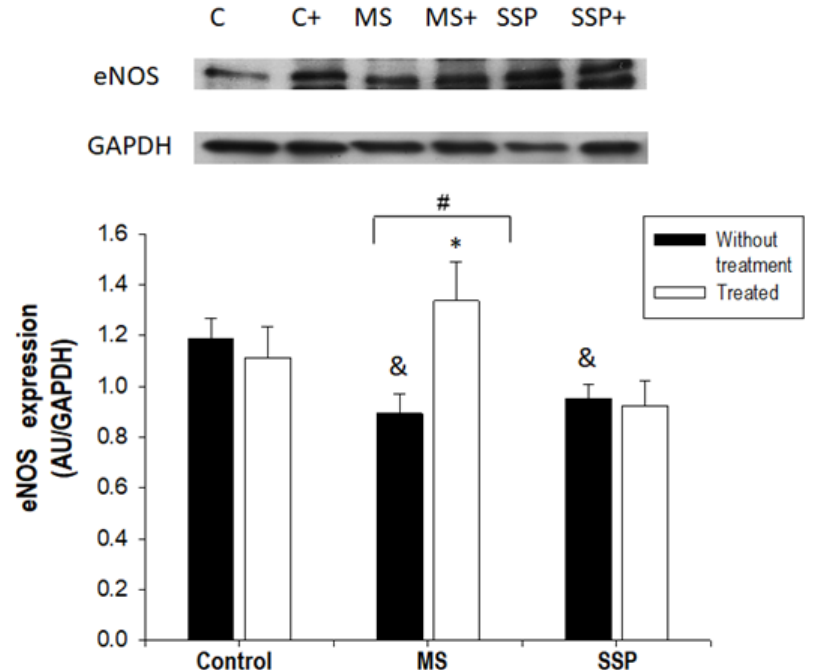
Figure 3. Effect of the treatment for 1 month (from 6 to 7 months of age) with RSV/QSC on the endothelial nitric oxide synthase (eNOS) expression in aorta homogenates after exposure to sucrose for a short- (SSP) and long- (MS) term period. A representative Western blot image is shown. Data represent the mean ± SEM of five different rats from each group. # p < 0.01; & p < 0.05 against C group without treatment; * p < 0.05 against SSP group with same treatment (after one-way ANOVA). Abbreviations: C = control; C+ = control treated with polyphenols; MS = metabolic syndrome; MS+ = metabolic syndrome treated with polyphenols; SSP = short sucrose period; SSP+ = short sucrose period treated with polyphenols.